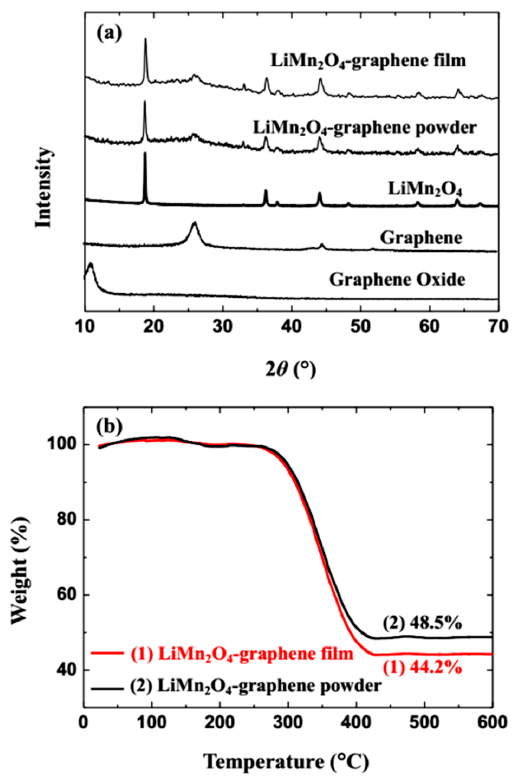
Figure 2. XRD patterns of samples ( a ), and thermogravimetric curves of LiMn 2 O 4 -graphene film and LiMn 2 O 4 -graphene powder ( b ).